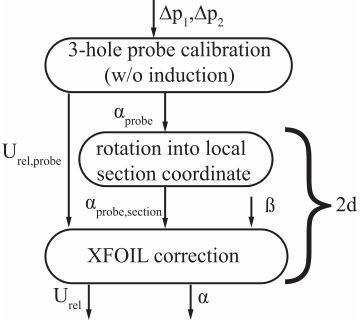
Figure 7. Flow chart for the estimation of angle of attack and veloc- ity from three-hole probe measurements (adapted from Klein et al.,